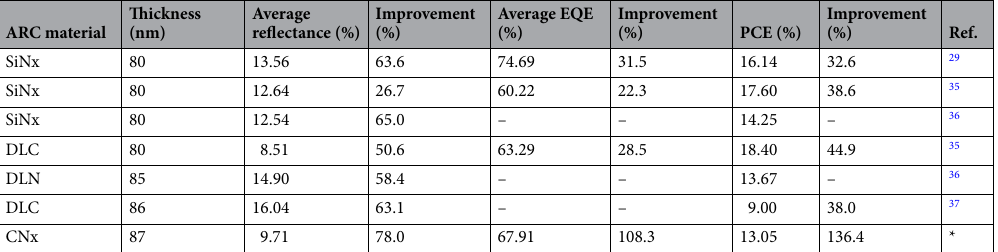
Table 1. Summary of the average reflectance, EQE, and PCE of silicon solar cells with different single layer ARC materials compared with the CNx ARC of the present work (*). The average was calculated in the wavelength range of 300–1100